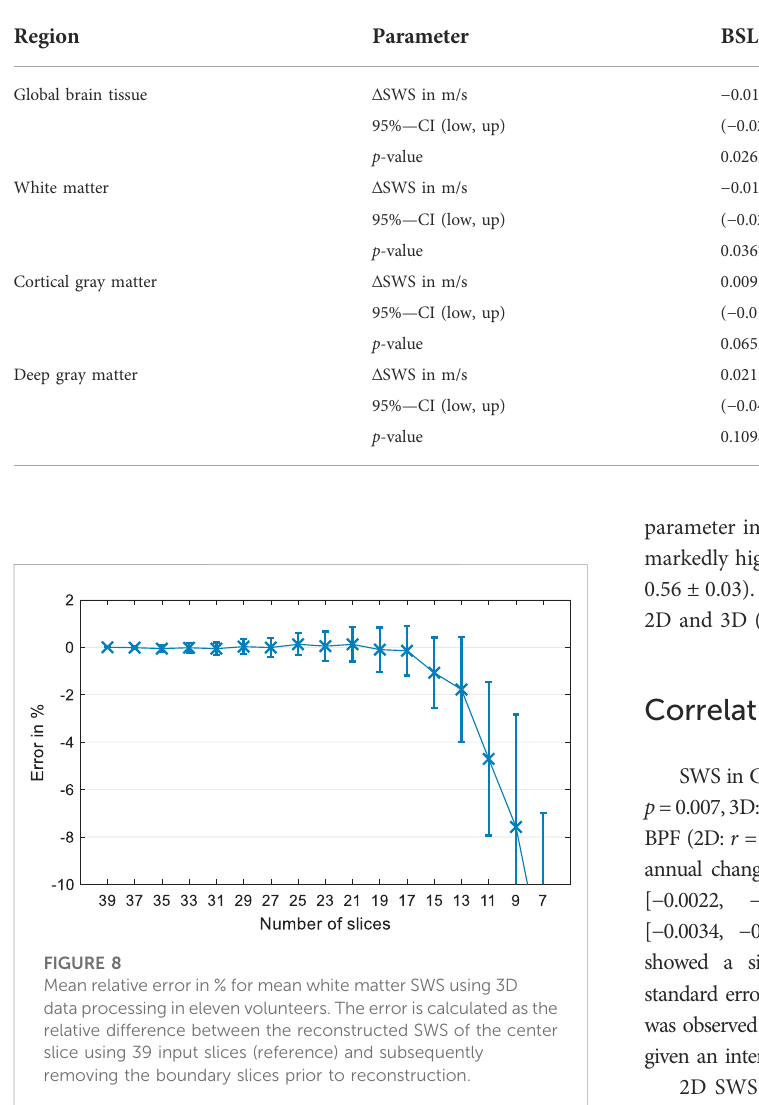
values for CGM (2D: 1.21 ± 0.03 m/s, 3D: 1.09 ± 0.05 m/s) compared with WM ( p < 0.0001 for each test). Group statistical plots for GBT, WM, CGM, and DGM in 2D and 3D are shown in Figure 3. A descriptive summary for all analyzed regions is given in Table 1, including region size and CV. Inter-subject variations as quanti fi ed by CV were smaller in 2D than 3D processing. CV in GBT, WM, CGM, and DGM was 2.3%, 1.8%, 2.5%, and 6.1% in 2D MRE versus 4.1%, 3.9%, 4.7%, and 6.7% in 3D MRE, respectively (see also Figure 7 and Table 3). Figure 4 shows a correlation plot for 2D and 3D SWS values for GBT. The results for both approaches were highly correlated ( r = 0.75, p < 0.0001).